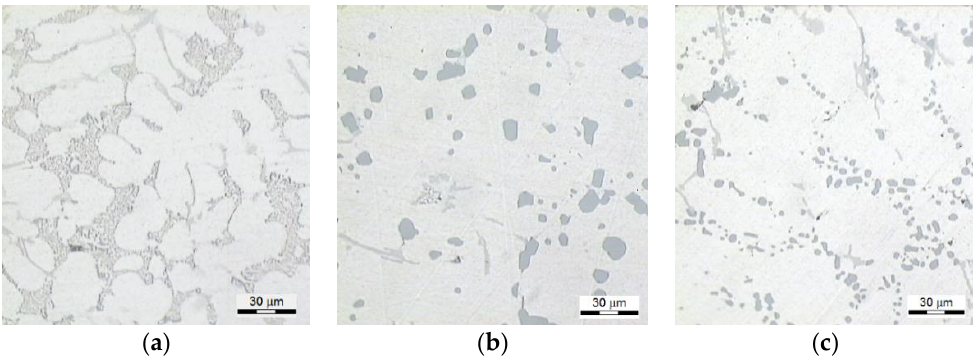
Figure 7. The microstructure of the alloy: ( a ) before the heat treatment—81 HBS, ( b ) for the system no. 27 (Table 2)—61 HBS, ( c ) for the system no. 13 (Table 2)—129 HBS.